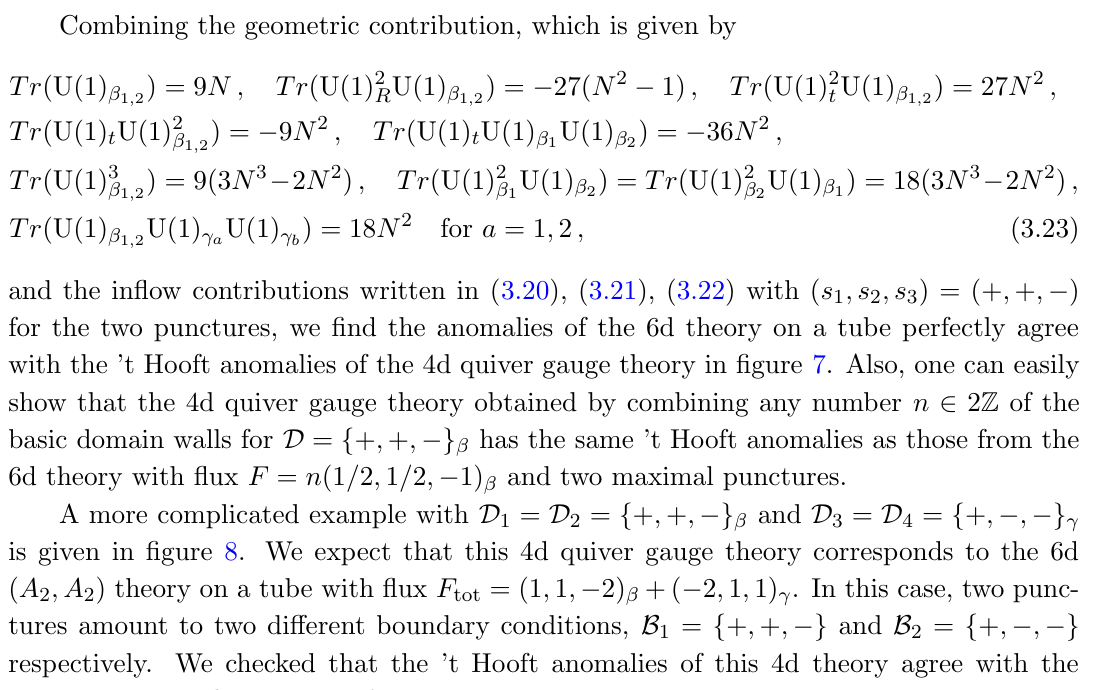
Figure 8 . A combination of four (cid:13)ux domain wall with F tot = (1 ; 1 ; (cid:0) 2) (cid:12) + ( (cid:0) 2 ; 1 ; 1) (cid:13) in the a(cid:14)ne A 2 quiver theory. The permutations in four domain walls are (cid:27) t 1 = (cid:27) t 2 = (1 2) (cid:12) and (cid:27) t 3 = (cid:27) t 4 = (2 3) (cid:13) , and thus Q 4 (cid:27) t i = i =1